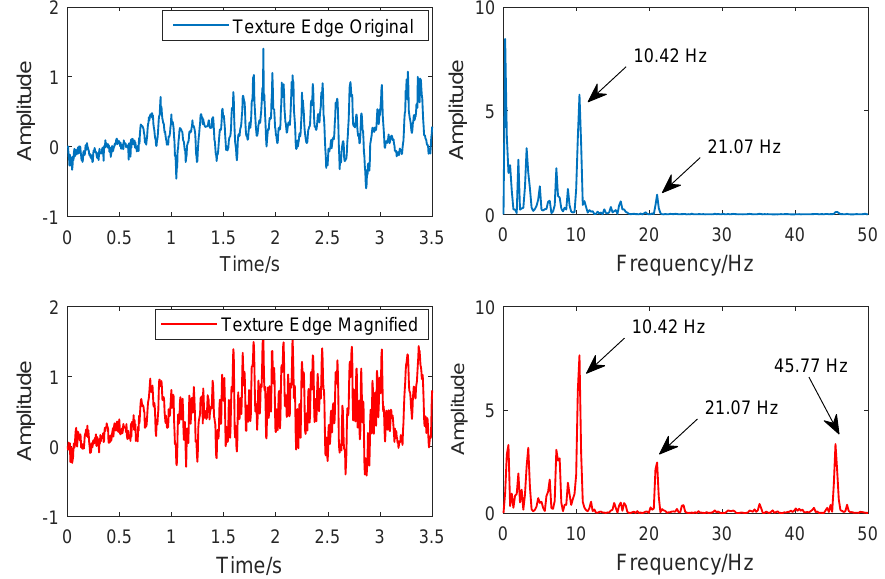
Figure 11. Vibration signals extracted from the original video and magnified video along the textured